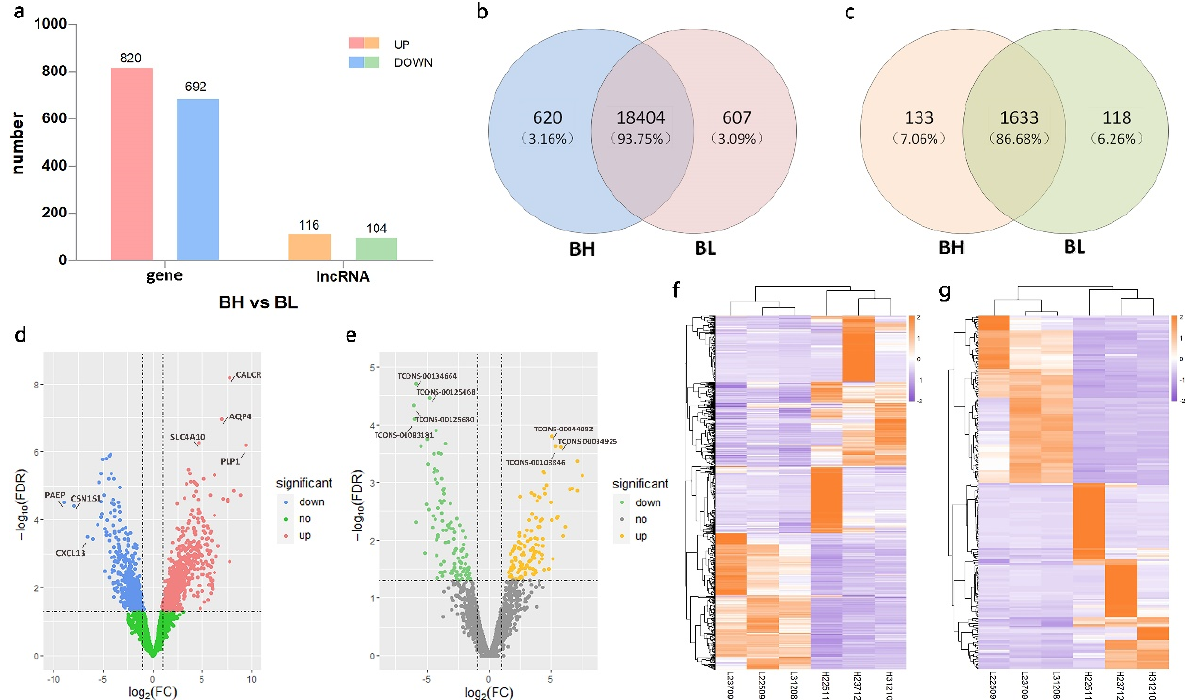
Figure 4. Expression of genes and long non-coding RNAs (lncRNAs) in extremely high- and low- backfat pigs based on biological replicate RNA sequencing (RNA-seq). ( a ) Number of differentially expressed lncRNAs (DELs) and differentially expressed genes (DEGs) between the BH and BL groups; ( b ) Venn diagram of genes from each group; ( c ) Venn diagram of lncRNAs from each group; ( d ) Volcano plot of DEGs; ( e ) Volcano plot of DELs; ( f ) Heatmap of DEGs in six samples. The color scale indicates the FPKM values. Orange indicates high expression and purple indicates low expression; ( g ) Heatmap of DELs in six samples. We have annotated the most significant DEGs and DELs in the volcano.